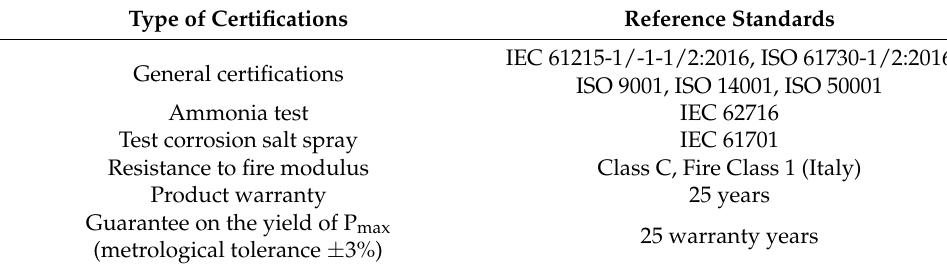
Table 4. Certifications and warranty.